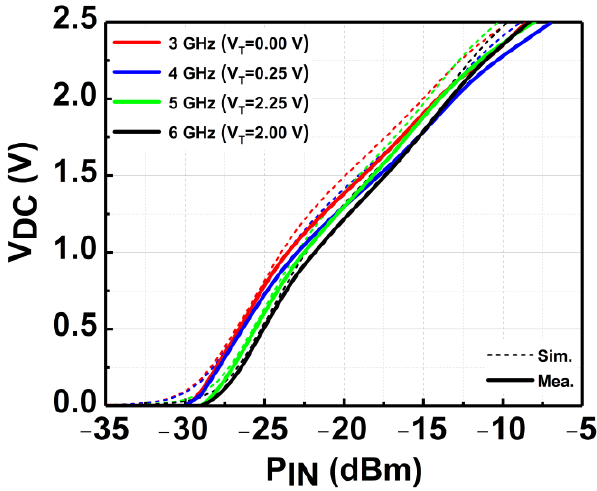
Figure 20. Measured tuned V DC of the CCDD-TVB rectifier across frequency.